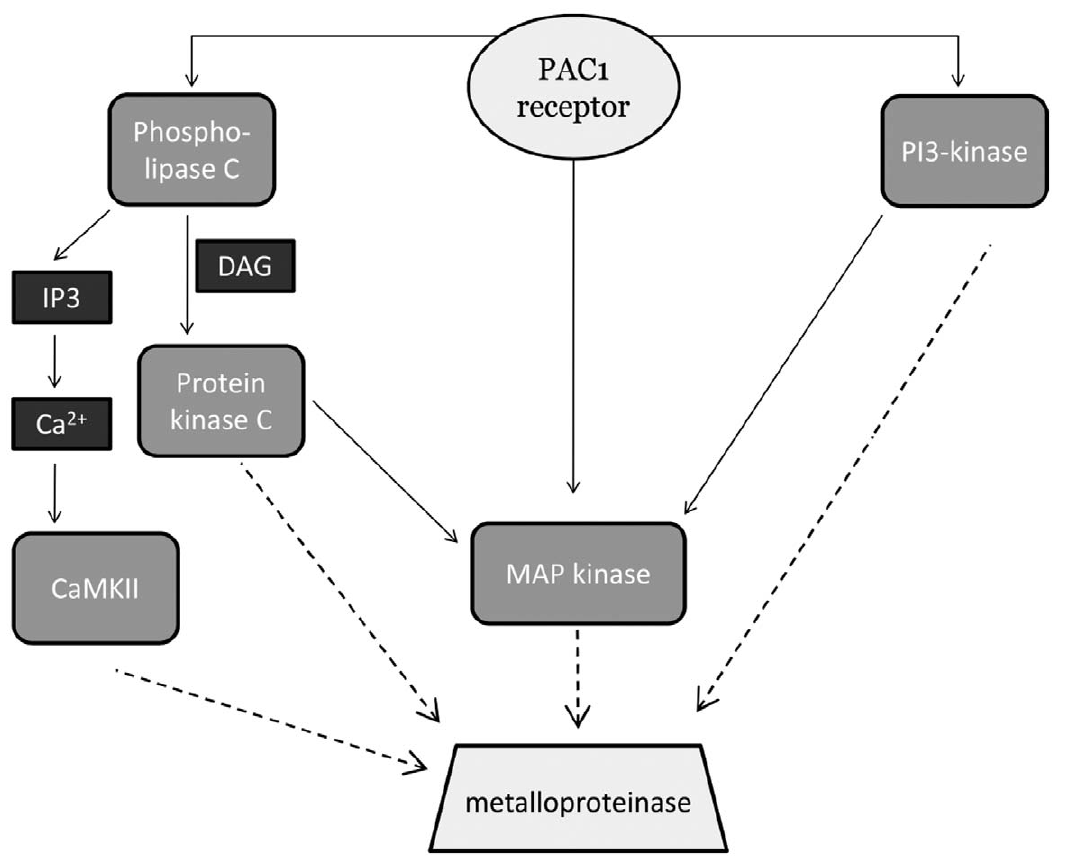
Figure 15. Model of the intracellular pathways involved in PACAP-induced RAGE shedding. In this study we demonstrated an involvement of MAP kinase, PI3-kinase, PKC and CaMKII in PAC1 receptor-induced activation of metalloproteinase-mediated RAGE shedding. Molecular mechanisms linking signaling cascades with metalloproteinase activation are still unknown (dotted lines). CaMKII: calmodulin-dependent protein kinase II; DAG: diacylglycerol; IP3: inositol 1,4,5-triphosphate; MAP kinase: mitogen-activated protein kinase; PI3-kinase: phosphatidylinositol 3-kinase.